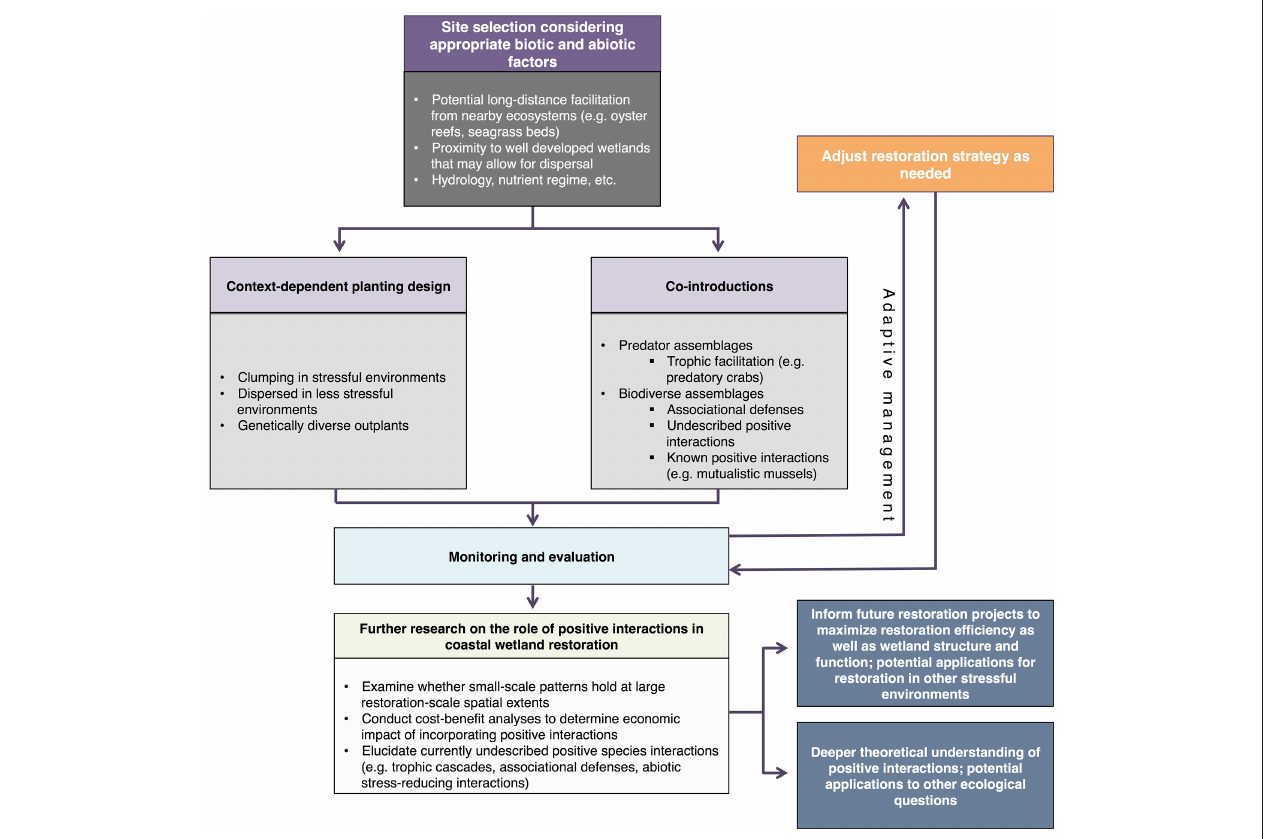
FIGURE 7 | Theoretical diagram describing a potential workflow for systematically incorporating positive species interactions into restoration